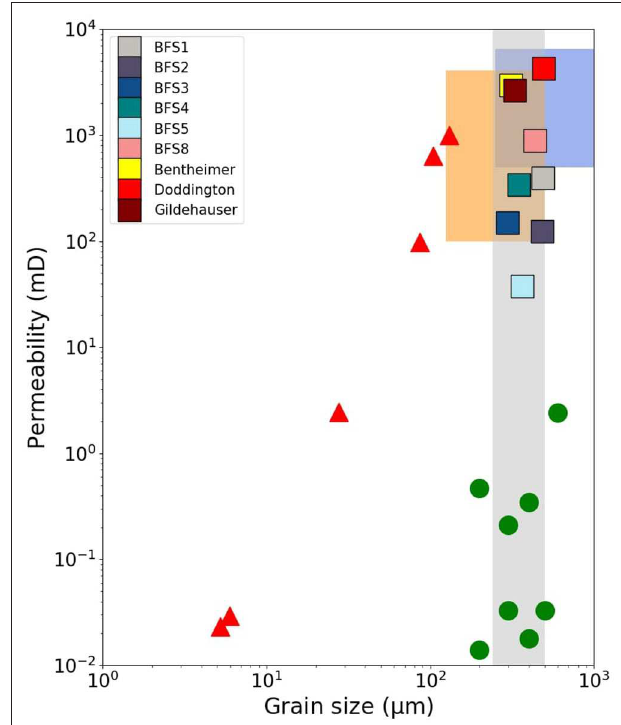
FIGURE 5 | Comparison between our data and previous studies of permeability as a function of grain size. The red triangles represent data from hydrate-free sediments ( Konno et al., 2015), while the green circles represent data from tight gas sandstones ( Becker et al., 2017). The shaded orange and blue regions correspond to fine to medium and medium to coarse grained intervals of the Piper Formation, respectively ( Maher, 1980). The shaded gray interval is the range of grain size measurements obtained by point-count analysis for the Brae Formation ( Maast et al.,